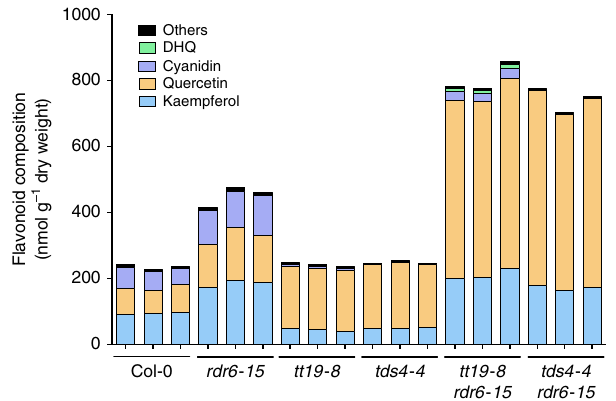
Fig. 5 Flavonoid composition of Col-0 and Arabidopsis mutant seedlings grown in AIC. Left to right, wild-type Col-0; single mutant rdr6-15 , tt19-8 , tds4-4 ; and double mutant tt19-8 rdr6-15 and tds4-4 rdr6-15 . Blue, kaempferol; orange, quercetin; purple, cyanidin; green, dihydroquercetin (DHQ); and black, others include apigenin, luteolin, naringenin, eriodictyol, dihydrokaempferol, pelargonidin, epicatechin, and peonidin. Source data are provided as a Source Data fi